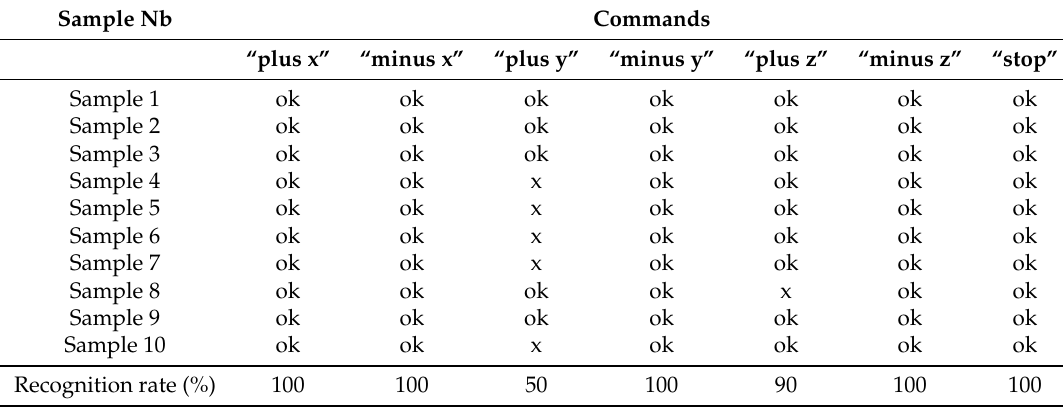
Table 4. Effects of 60 dB interference on the robot’s